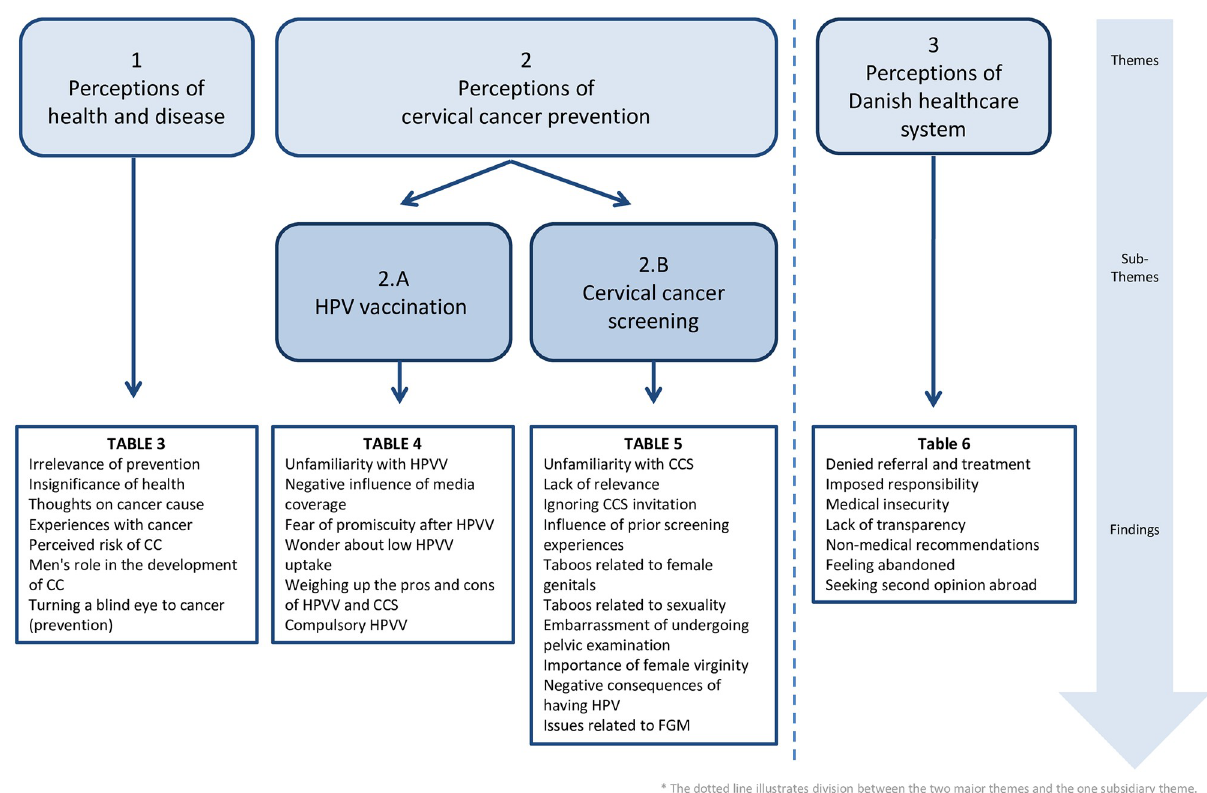
Fig 1. Overview of themes, sub-themes and findings.